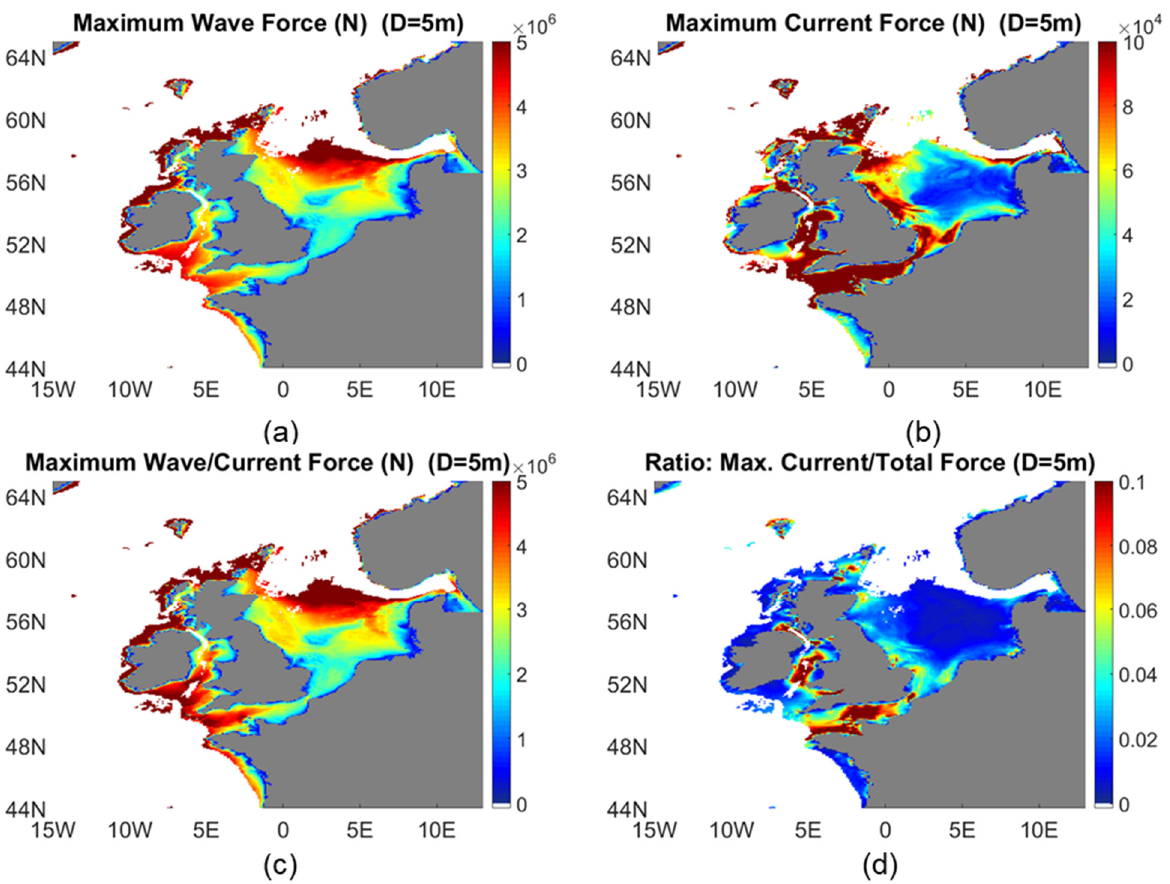
Figure 6. Spatial maps of maximum wave/current force ( a ), current force ( b ), maximum wave force ( c ) and ratio of current contribution to total force ( d ), on a pile of diameter D = 5 m and deployment depth up to 100 m, from Met Office FOAM and WaveWatch III model outputs on the AMM7 grid over period July 2014 to June 2016.